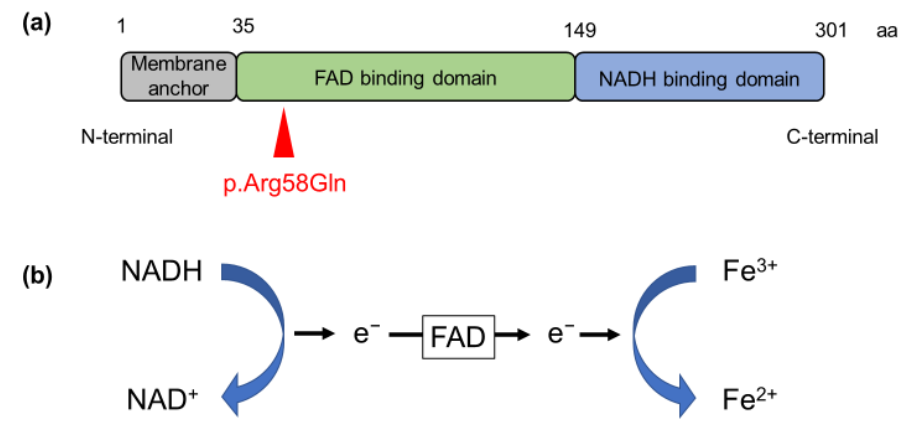
Figure 2. Enzymatic activity of CYB5R3. ( a ) Structure of CYB5R3 protein. CYB5R3 is composed of three domains. The variant we identified is shown by a red arrowhead. ( b ) The process by which iron (Fe) ions are reduced by CYB5R3. Flavin adenine dinucleotide (FAD) is responsible for the transfer of electrons. Abbreviations: aa: amino acid; NADH: nicotinamide adenine dinucleotide cytochrome; NAD: nicotinamide adenine dinucleotide.